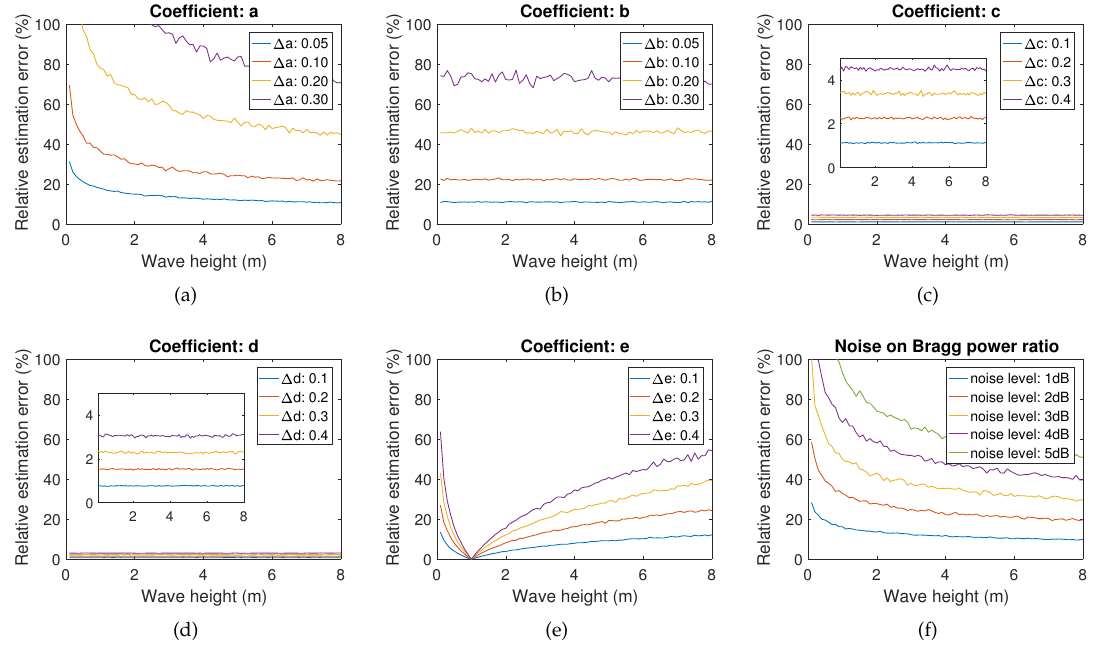
Figure 4. Effects of fluctuations of different fitting coefficients such as ( a ) a , ( b ) b , ( c ) c , ( d ) d and ( e ) e , and ( f ) noise added to the Bragg power ratio on the estimation of wave